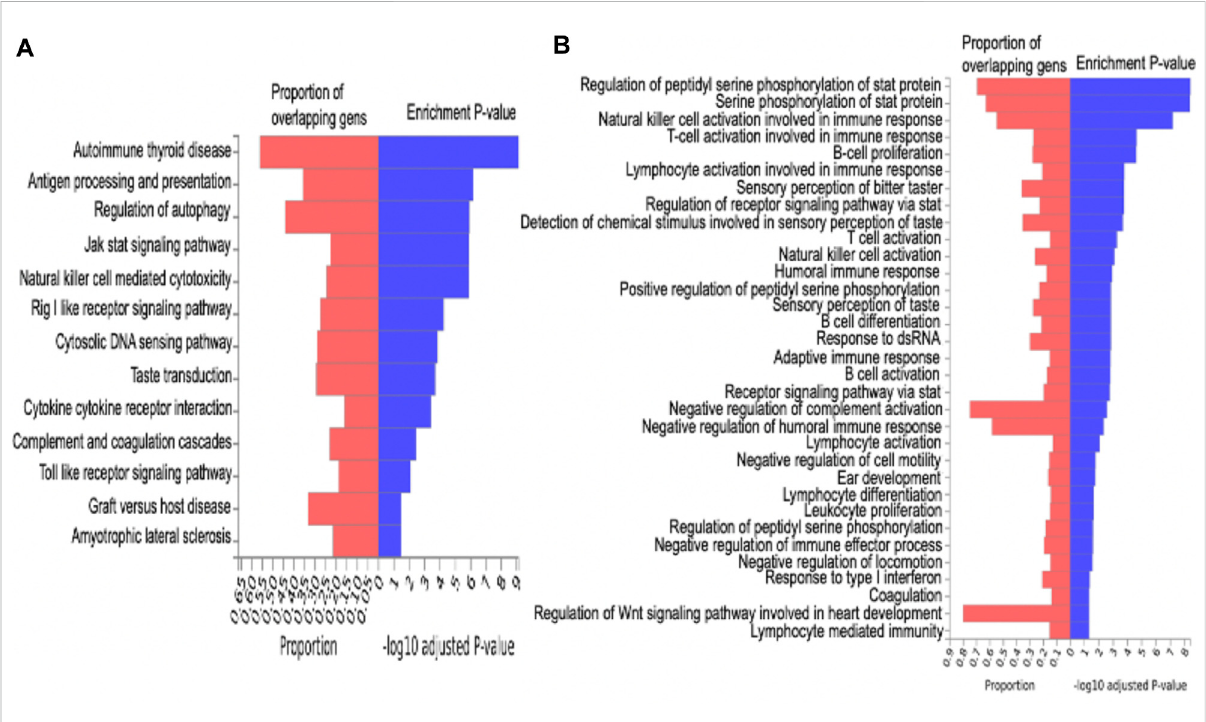
FIGURE 2 Enrichment analysis. Figure A is the KEGG pathway analysis for functional enrichment clustering analysis. Figure B is gene ontology (GO) enrichment